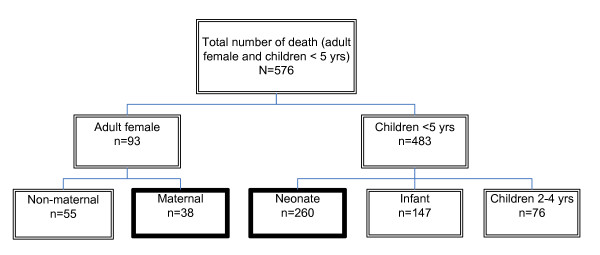
Numbers of deaths by categories.